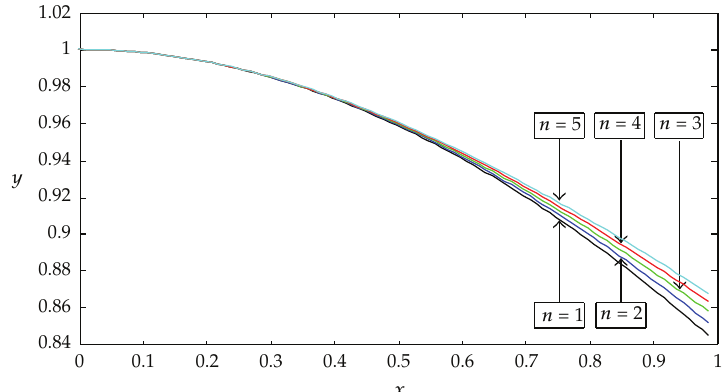
Figure 4: Numerical solutions of Example 4.2 for di ff erence n